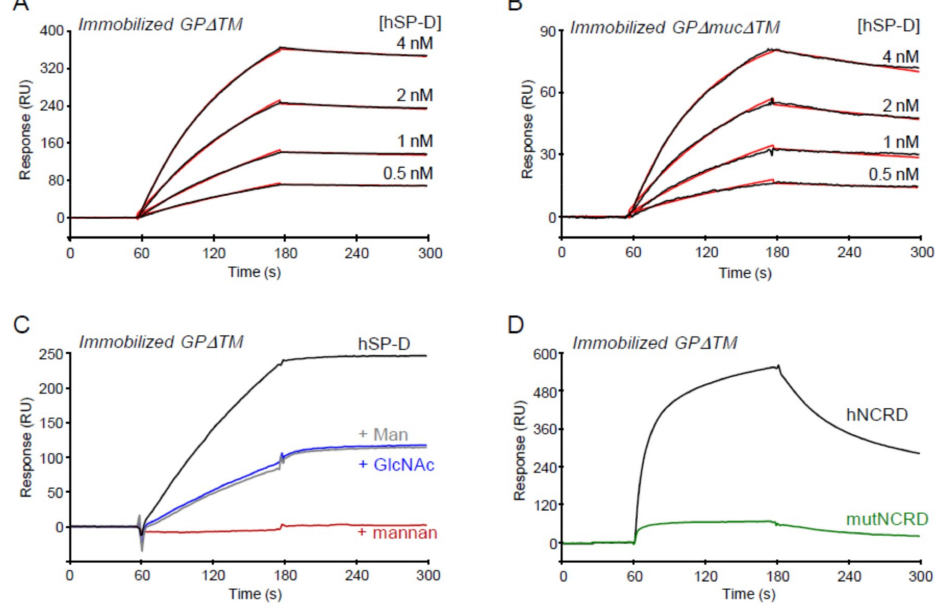
Figure 2. Characterization of the interaction of hSP-D with immobilized GP ∆ TM by SPR. ( A , B ) hSP-D samples (40 µ L) were injected at the indicated concentrations over immobilized GP ∆ TM (4,700 RU, panel A) or GP ∆ muc ∆ TM (2,500 RU, panel B) in 20 mM HEPES, 150 mM NaCl, 5 mM CaCl 2 , 0.005% surfactant P20, and pH 7.4 (HBSCa-P). Fits are shown as red lines and were obtained via global fitting of the data using a 1:1 Langmuir binding model. ( C ) hSP-D (3.8 nM) was injected over GP ∆ TM (8000 RU) in HBSCa-P containing 5 mM mannose (Man), and 10 mM N-acetyl-glucosamine